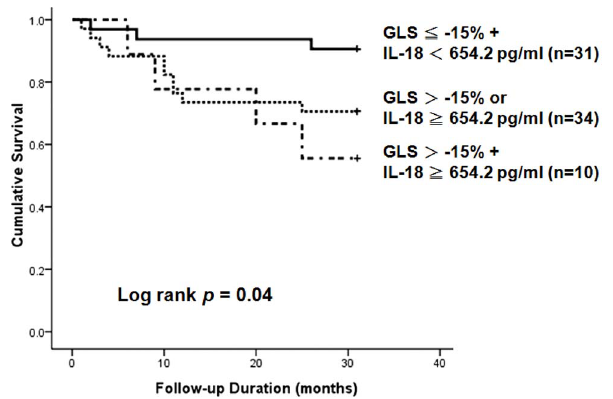
Figure 2. Kaplan-Meier survival curves of all-cause mortality in clinically stable hemodialysis patients using the cutoff values of interleukin (IL)-18 and left ventricular global peak systolic longitudinal strain (GLS). Clinically stable hemodialysis patients with high IL-18 levels ( $ 667 pg/ml) and less negative GLS ( .2 15%) had the worst